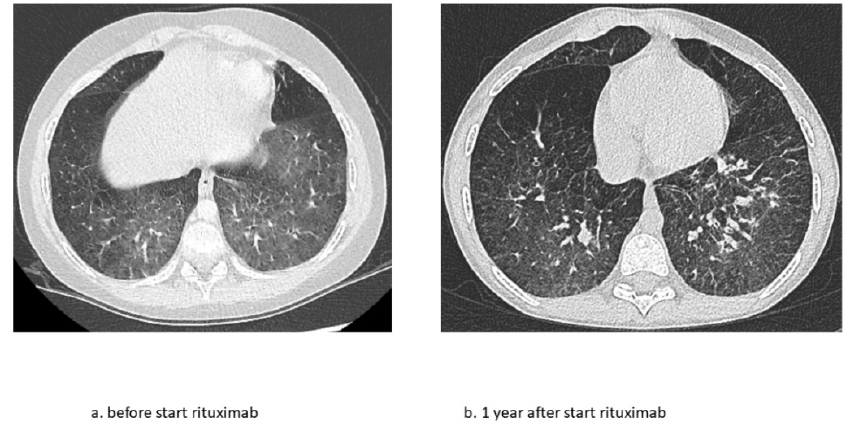
Figure 1. Chest CT scan images before and 1 year after start of RTX treatment during clinically stable disease phase. ( a ) Shows ground glass opacifications as main abnormality and ( b ) less well-defined ground glass but more interlobular septal thickening after 1 year of RTX.